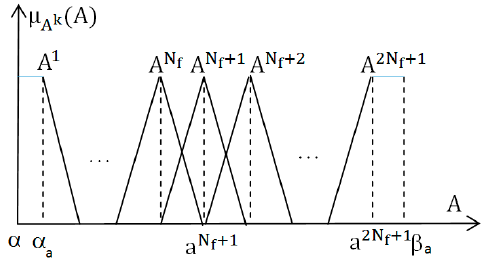
Figure 1. The membership function of the input.